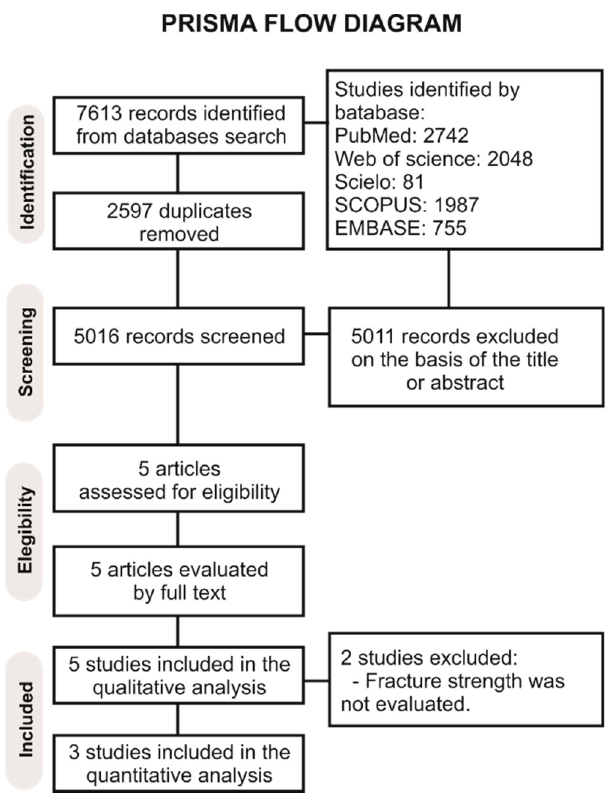
Figure 1. Prisma flow diagram of the study.